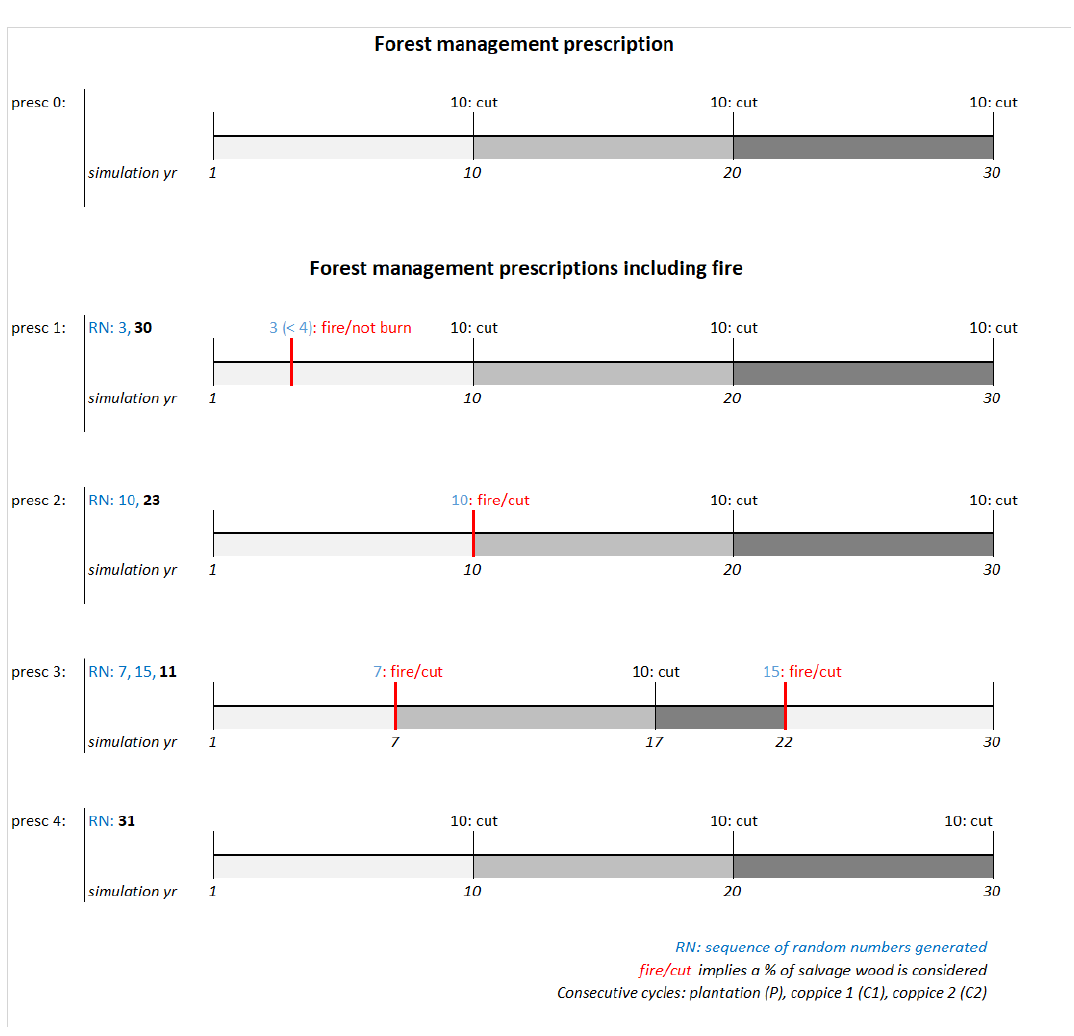
Figure A1. Examples of forest management prescriptions for a simulation period of 30 years, where the various prescriptions illustrate the following cases: no fire and a prescribed harvest age of 10 years (presc 0); a fire that does not damage the stand (presc 1); fire at a prescribed harvest age (% of salvage wood considered) (presc 2); fires in more than one cycle anticipating harvest age and forcing the simulation into the next cycle (% of salvage wood considered) (presc 3); and no fire occurring during the simulation period (presc 4).